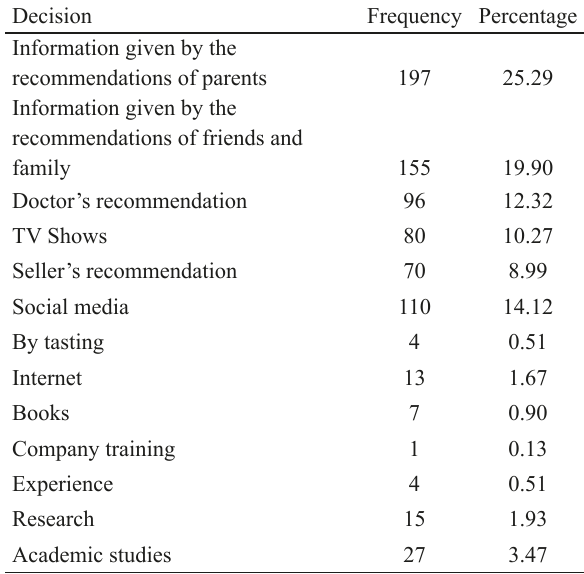
Table 6. Distributions of Participants’ Decision-Making about Medicinal and Aromatic